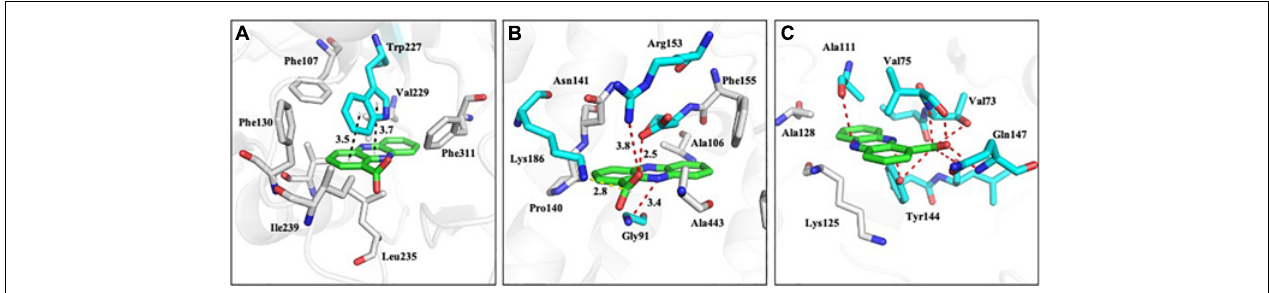
FIGURE 11 | The proposed mode of interaction between PCA and proteins involved in N -glycan biosynthesis of Ps. camelliae-sinensis strain GZHS-2017-010. The PCA and protein are shown in the purple and green stick model, respectively. The hydrogen bond is shown in black dashed lines. (A–C) represent Glycolipid 2-alpha-mannosyltransferase, glycoside hydrolase 3, and Mannan polymerase II complex, respectively.